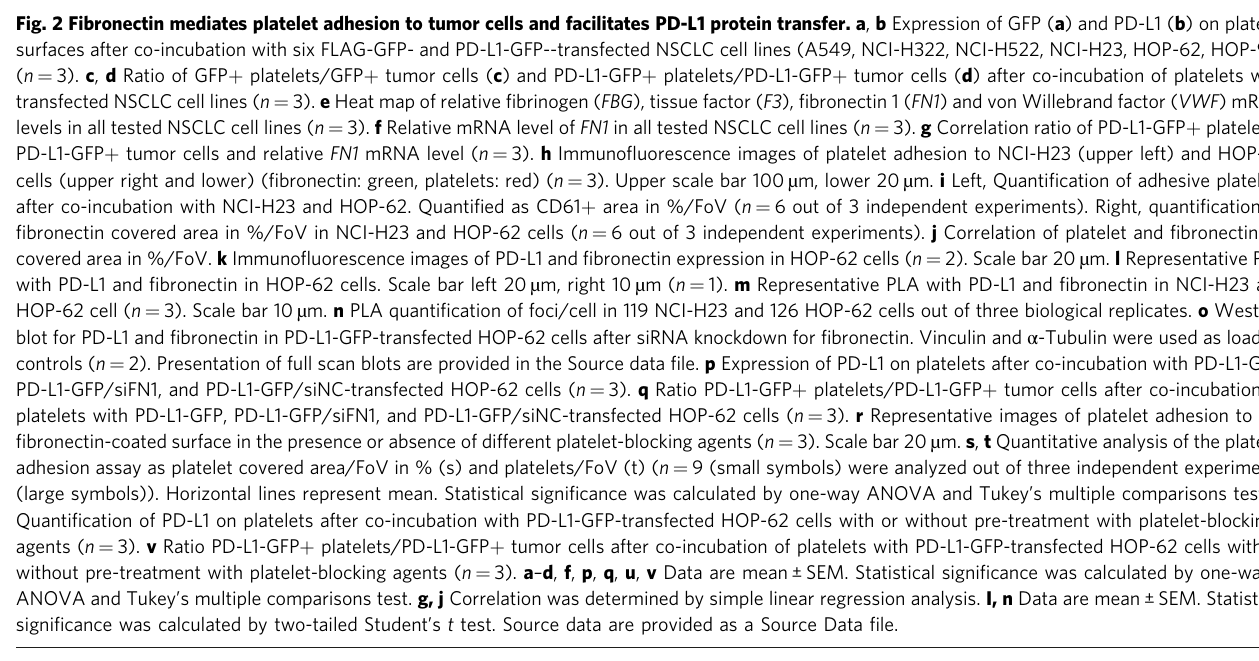
Fig. 2 Fibronectin mediates platelet adhesion to tumor cells and facilitates PD-L1 protein transfer. a , b Expression of GFP ( a ) and PD-L1 ( b ) on platelet surfaces after co-incubation with six FLAG-GFP- and PD-L1-GFP--transfected NSCLC cell lines (A549, NCI-H322, NCI-H522, NCI-H23, HOP-62, HOP-92) ( n = 3). c , d Ratio of GFP + platelets/GFP + tumor cells ( c ) and PD-L1-GFP + platelets/PD-L1-GFP + tumor cells ( d ) after co-incubation of platelets with transfected NSCLC cell lines ( n = 3). e Heat map of relative fi brinogen ( FBG ), tissue factor ( F3 ), fi bronectin 1 ( FN1 ) and von Willebrand factor ( VWF ) mRNA levels in all tested NSCLC cell lines ( n = 3). f Relative mRNA level of FN1 in all tested NSCLC cell lines ( n = 3). g Correlation ratio of PD-L1-GFP + platelets/ PD-L1-GFP + tumor cells and relative FN1 mRNA level ( n = 3). h Immuno fl uorescence images of platelet adhesion to NCI-H23 (upper left) and HOP-62 cells (upper right and lower) ( fi bronectin: green, platelets: red) ( n = 3). Upper scale bar 100 µ m, lower 20 µ m. i Left, Quanti fi cation of adhesive platelets after co-incubation with NCI-H23 and HOP-62. Quanti fi ed as CD61 + area in %/FoV ( n = 6 out of 3 independent experiments). Right, quanti fi cation of fi bronectin covered area in %/FoV in NCI-H23 and HOP-62 cells ( n = 6 out of 3 independent experiments). j Correlation of platelet and fi bronectin covered area in %/FoV. k Immuno fl uorescence images of PD-L1 and fi bronectin expression in HOP-62 cells ( n = 2). Scale bar 20 µ m. l Representative PLA with PD-L1 and fi bronectin in HOP-62 cells. Scale bar left 20 µ m, right 10 µ m ( n = 1). m Representative PLA with PD-L1 and fi bronectin in NCI-H23 and HOP-62 cell ( n = 3). Scale bar 10 µ m. n PLA quanti fi cation of foci/cell in 119 NCI-H23 and 126 HOP-62 cells out of three biological replicates. o Western blot for PD-L1 and fi bronectin in PD-L1-GFP-transfected HOP-62 cells after siRNA knockdown for fi bronectin. Vinculin and α -Tubulin were used as loading controls ( n = 2). Presentation of full scan blots are provided in the Source data fi le. p Expression of PD-L1 on platelets after co-incubation with PD-L1-GFP, PD-L1-GFP/siFN1, and PD-L1-GFP/siNC-transfected HOP-62 cells ( n = 3). q Ratio PD-L1-GFP + platelets/PD-L1-GFP + tumor cells after co-incubation of platelets with PD-L1-GFP, PD-L1-GFP/siFN1, and PD-L1-GFP/siNC-transfected HOP-62 cells ( n = 3). r Representative images of platelet adhesion to